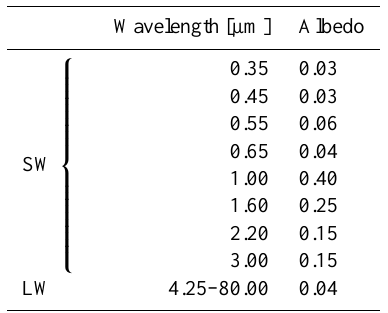
Table 1. Spectral dependence of the surface albedo in the RTM for simulations with the land